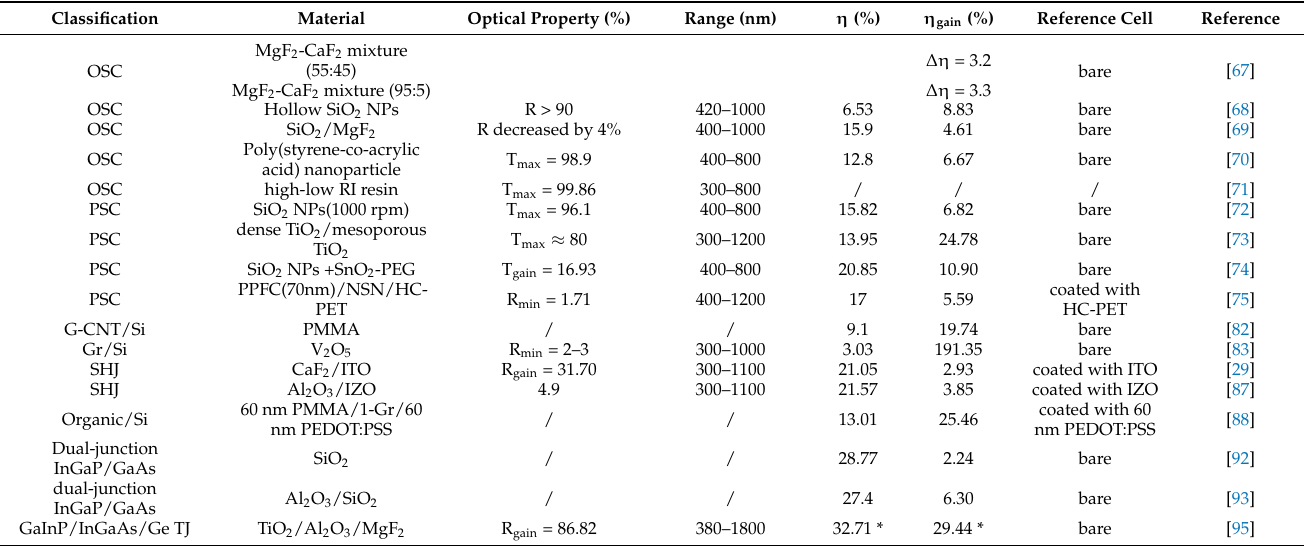
Table 3. The optical and electrical parameters of the third generation of solar cells with different ARCs. (* represents the simulated